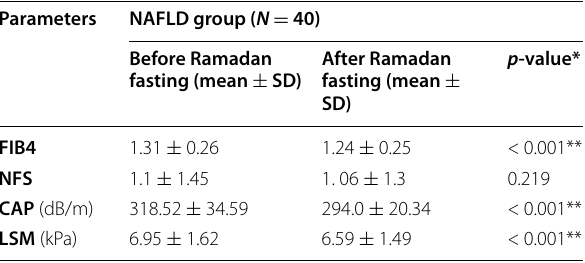
Table 2 Comparison of the liver parameters between before and after Ramadan fasting in the study